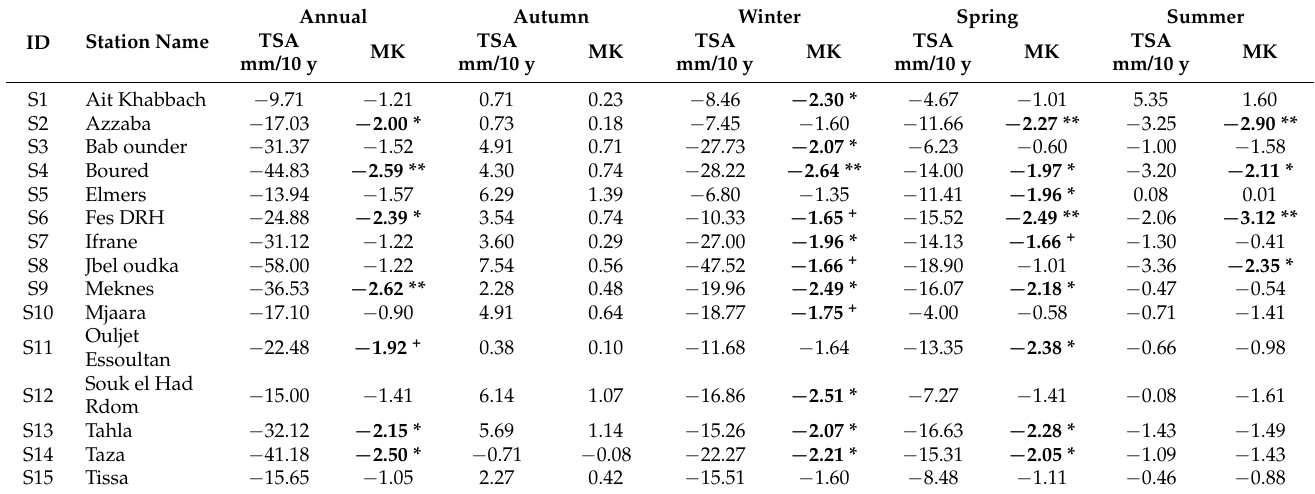
Table 2. Results of Theil–Sen approach (TSA) and Mann–Kendall (MK) test for annual and seasonal rainfall.